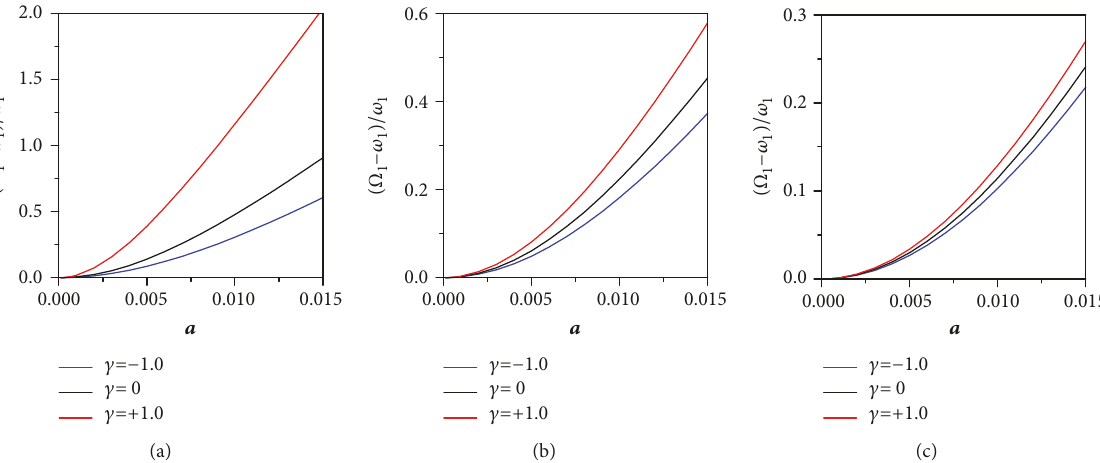
Figure 2: Frequency response curves of nonlinear free vibrations: (a) hinged-hinged; (b) hinged-fixed; (c) fixed-fixed.